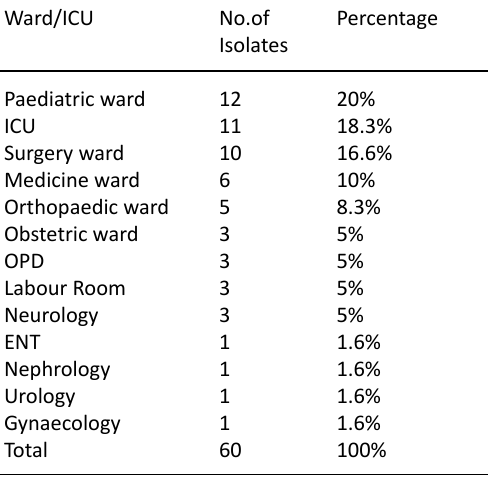
Table 1. Ward wise distribution of Coagulase Negative